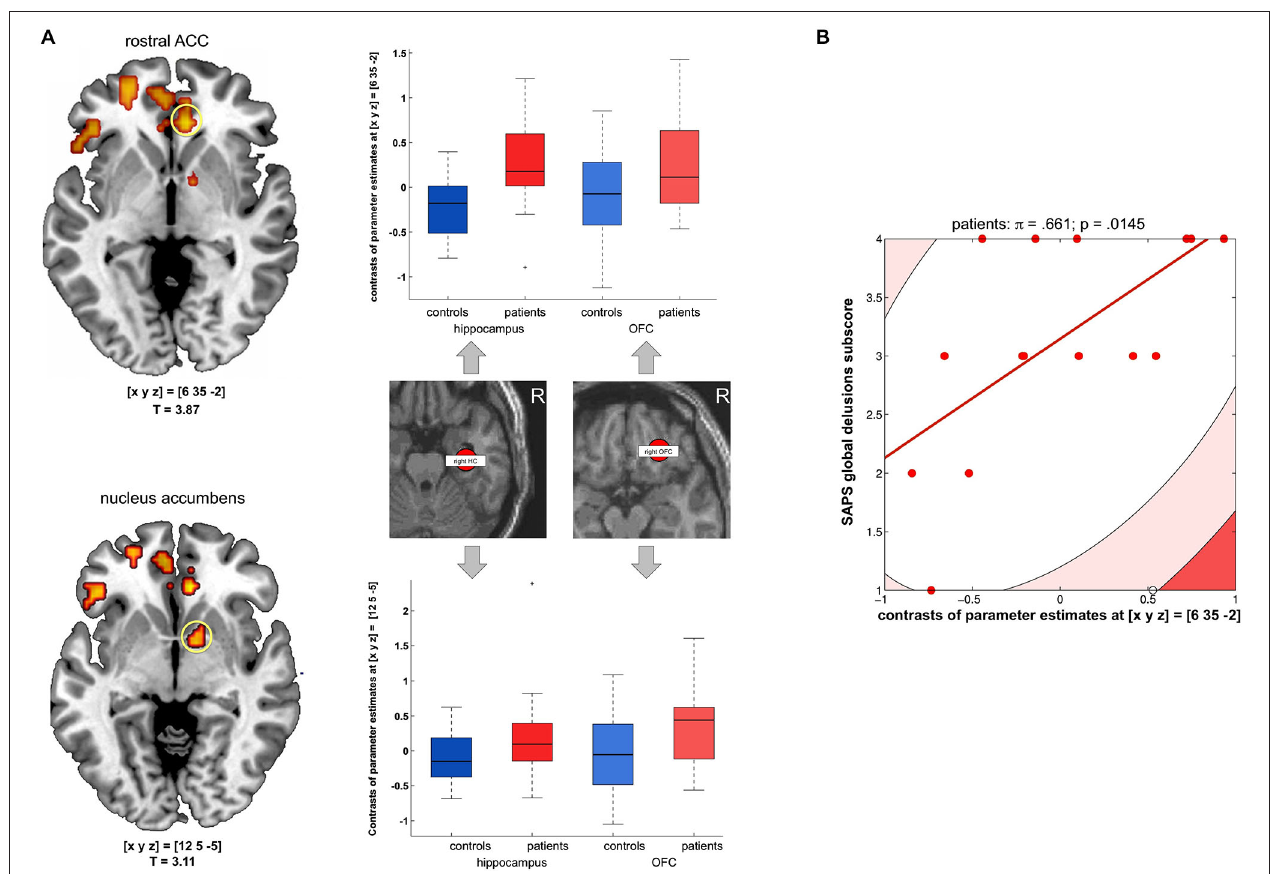
small-volume FWE-corrected for a combined anatomical and probabilistic rACC ROI (Holtmann et al., 2013). (B) Scatter plot depicting Shepherd’s pi correlation of the difference between hippocampal and orbitofrontal connectivity (contrasts of parameter estimates) and global delusion subscores of the scale for the assessment of positive symptoms (SAPS) (applicable to patients only). The correlation survived Bonferroni correction for the two correlations computed (sum and difference of the contrasts of parameter estimates reflecting hippocampal and orbitofrontal connectivity to the